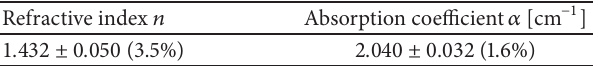
Table 2: The variation of the refractive index and the absorption coefficient for 0.3THz for green paper with determined